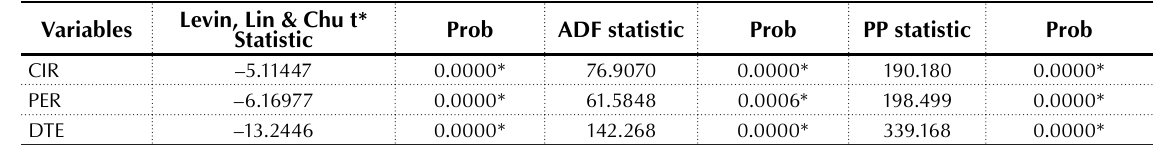
Source: researcher’s computation